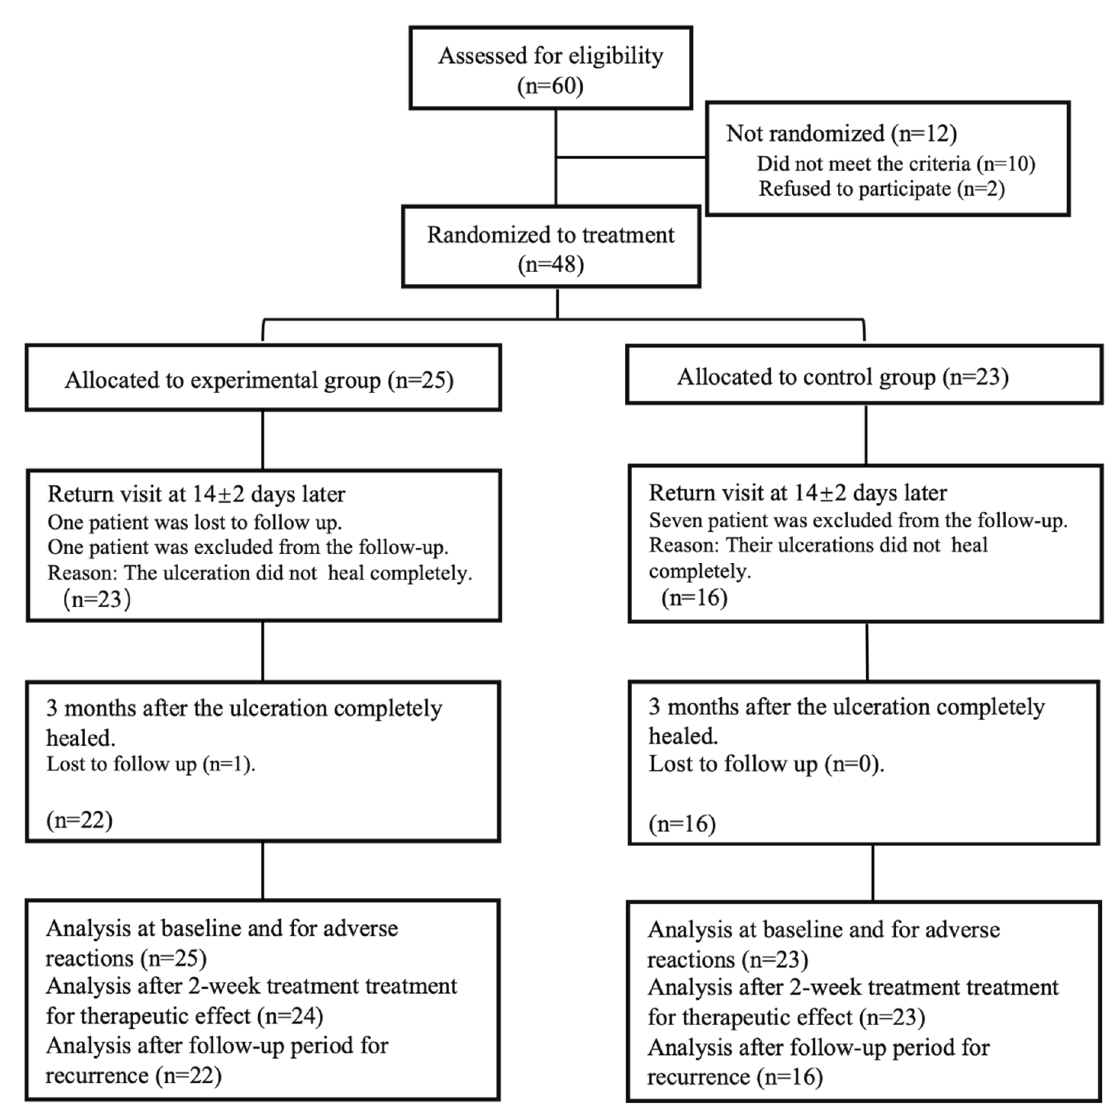
Figure 1. The flow diagram of the trial.